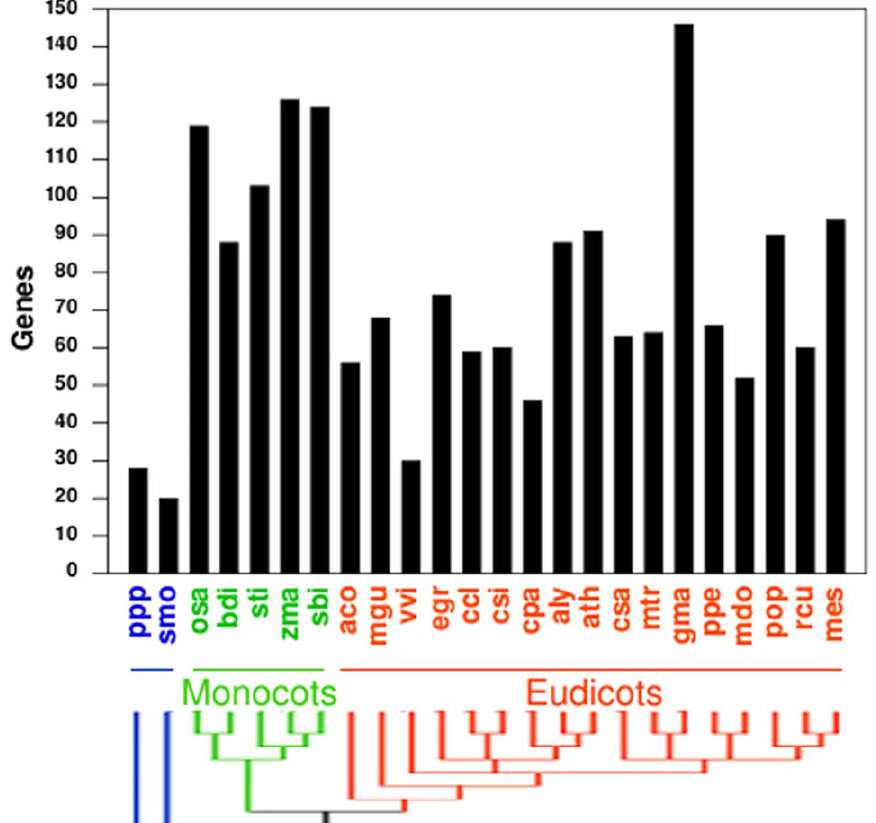
Figure 1. Number of retrieved ATL s in 24 plant species. The phylogenetic relationship between the 24 plant species is displayed at the bottom; it was adapted from the National Center of Biotechnology Information (NCBI) taxonomy server (http://www.ncbi.nlm.nih.gov/Taxonomy). The three major groups of plants are: basal plants (blue), monocots (green) and eudicots (orange). The species abbreviation is: ppp, Physcomitrella patens ; smo, Selaginella moellendorfii ; osa, Oryza sativa ; bdi, Brachypodium distachyon ; sit, Setaria italica ; zma, Zea mays ; sbi, Sorghum bicolor ; aco, Aquilegia coerulea ; mgu, Mimulus guttatus ; vvi, Vitis vinifera ; egr, Eucalyptus grandis ; ccl, Citrus clementina ; csi, Citrus sinensis ; cpa, Carica papaya ; aly, Arabidopsis lyrata ; ath, Arabidopsis thaliana ; csa, Cucumis sativus ; mtr, Medicago truncatula ; gma, Glycine max ; ppe, Prunus persica ; mdo, Malus domestica ; pop, Populus trichocarpa ; rcu, Ricinus communis ; mes, Manihot esculenta .